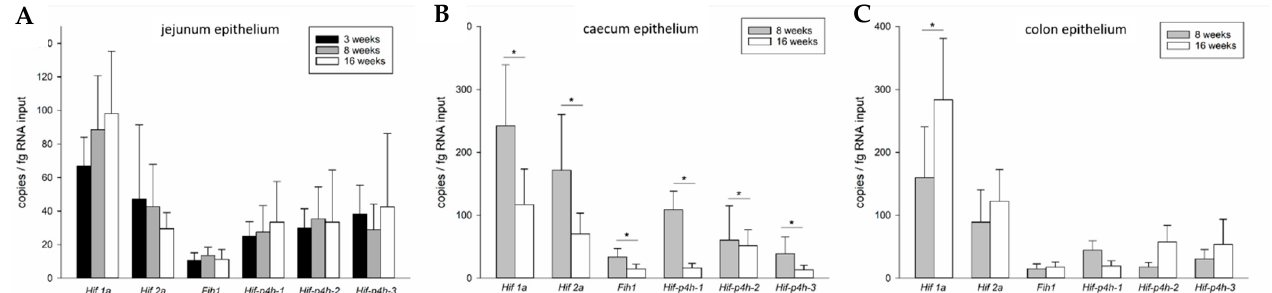
Figure 2. Age-dependent expression of HIF pathway components in the murine gastrointestinal epithelium. mRNA expression levels of Hif1a , Hif2a , Fih1 , Hif-p4h isoforms 1 , 2 , 3 and P4h-tm in wild-type mouse jejunum ( A ), caecum ( B ) and colon ( C ) epithelium at different ages. Jejunum: n = 6 for 3 weeks and n = 14 for 8 and 16 weeks; colon and caecum: n = 8; data are presented as means ± SD, One-Way RM ANOVA and subsequent Holm-Sidak or Dunn’s test, asterisks indicate significant differences ( p < 0.05) in the expression level of the same gene in the different age groups.